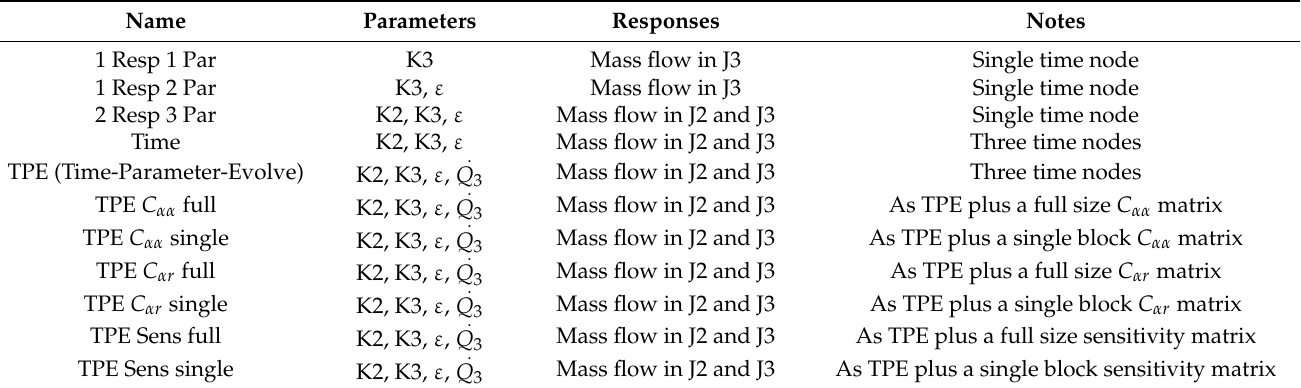
Table 1. Test cases matrix.